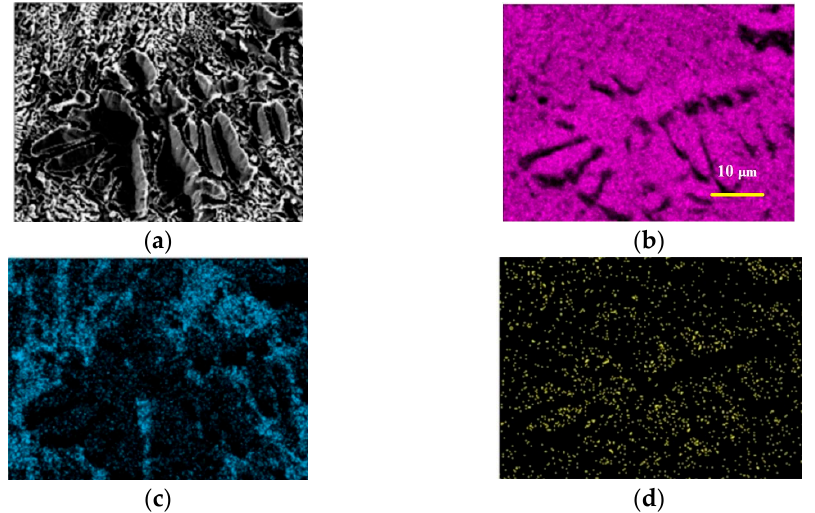
Figure 6. Element distribution map of melted area with laser remelting. ( a ) SEM micrograph; ( b ) Mo; ( c ) Si; ( d ) B.